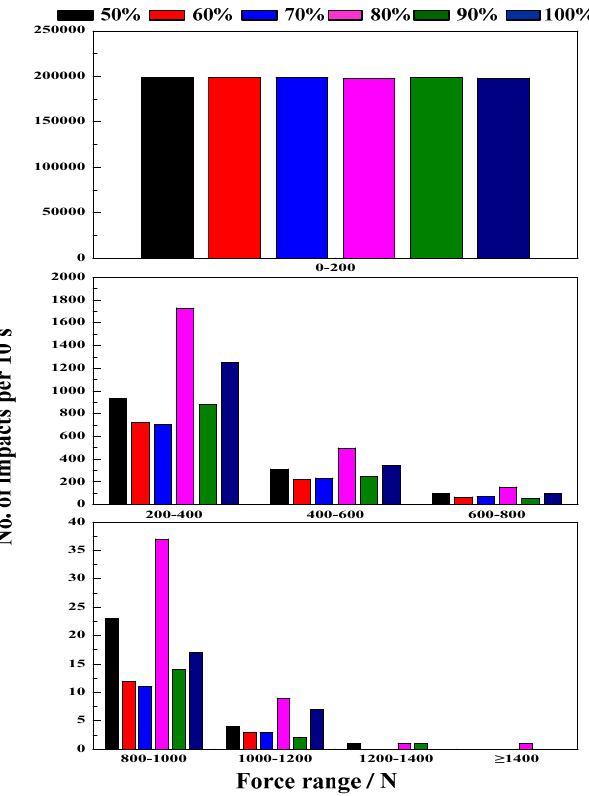
Figure 9. Impact force at different grinding media filling.